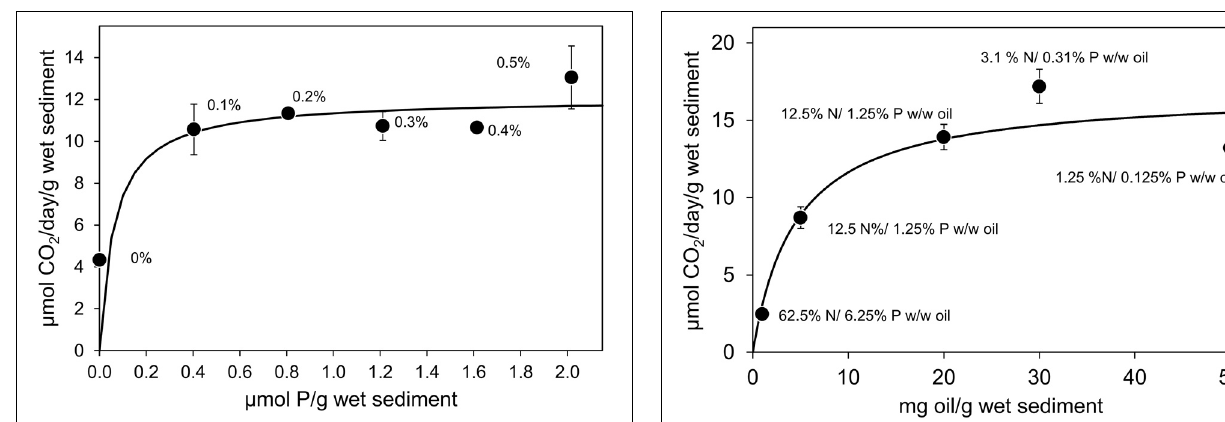
FIGURE 2 | Effect of inorganic phosphorus (0–0.5% P w/w of oil) with constant nitrogen concentration (3% N w/w of oil) on the rate of CO 2 production in microcosms containing 10g beach sediments and 125mg North Sea crude oil. Data are plotted as micromoles P/g sediment with the equivalent %P w/w of oil annotated next to each data point. Sodium nitrate and potassium dihydrogen phosphate were used as N and P sources. Each data point represents the average value of three replicates. Where error bars are not seen they are smaller than the symbols.